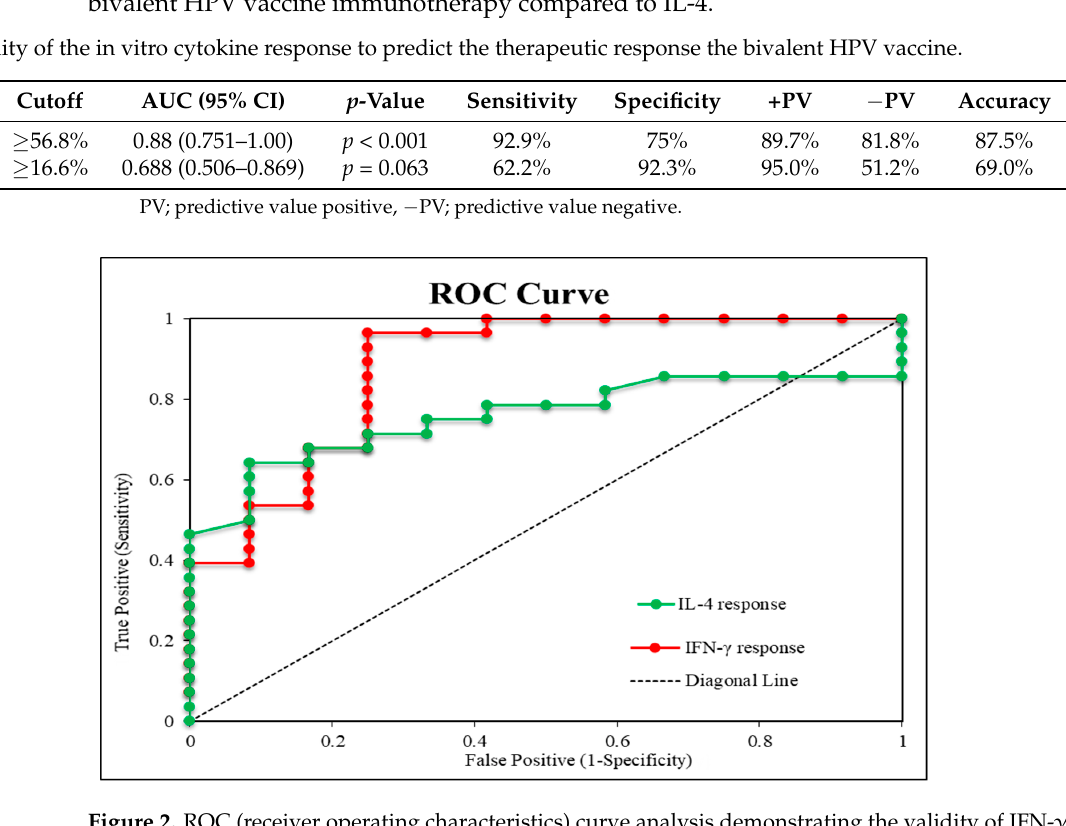
Figure 2. ROC (receiver operating characteristics) curve analysis demonstrating the validity of IFN- γ and IL-4 response in predicting the therapeutic response to immunotherapy in wart patients ( n = 40).